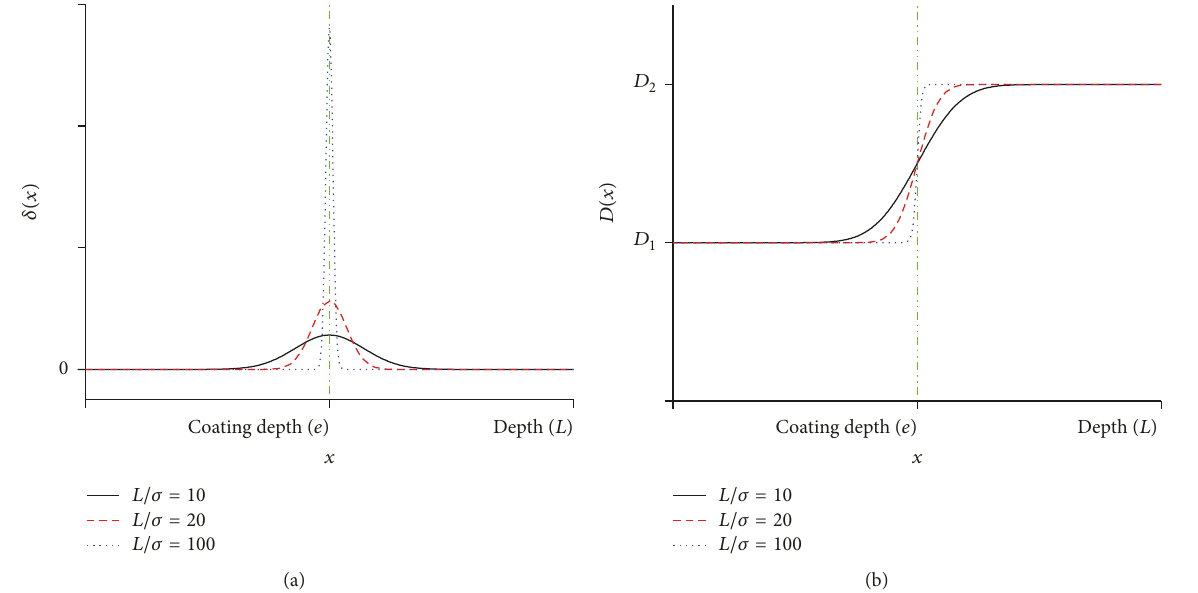
Figure 1: (a) Dirac-delta function and (b) 𝐷(𝑥) expression of Heaviside